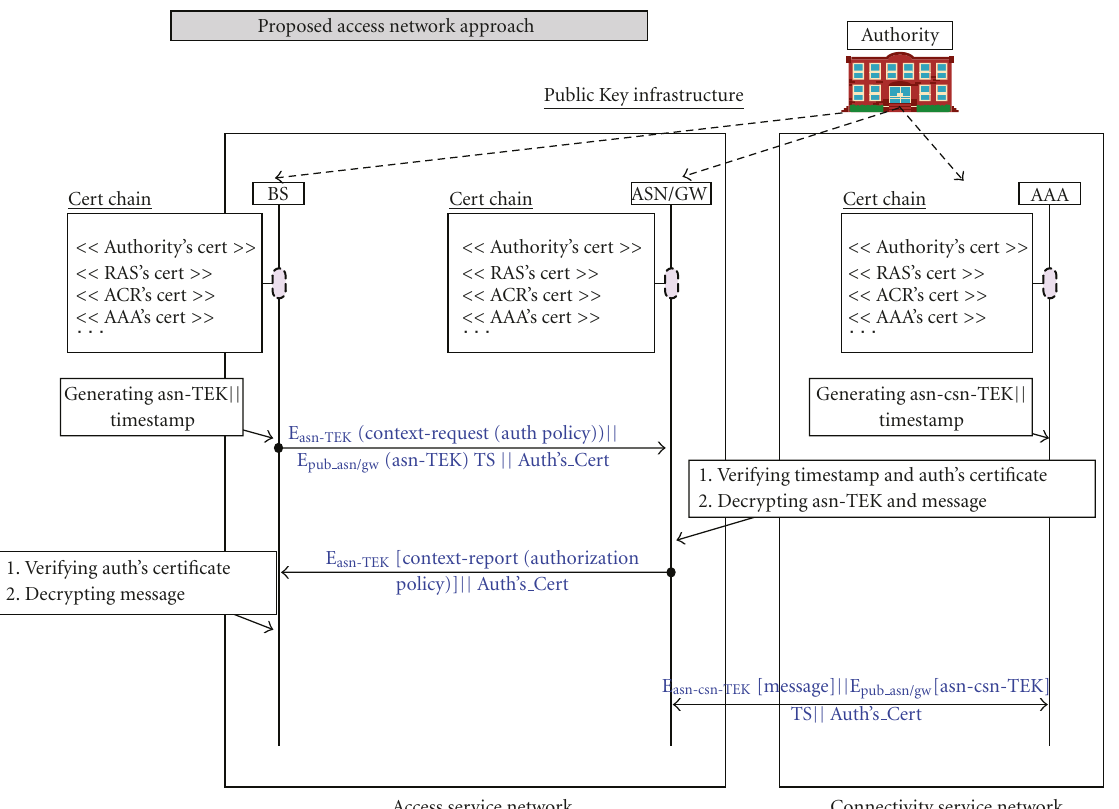
Figure 6: Proposed handover security